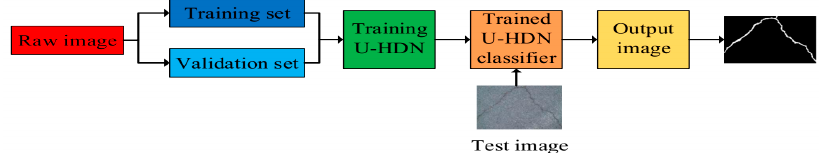
Figure 2. Flowchart for detecting pavement cracks. Materials 2020 , 13 , x FOR PEER REVIEW